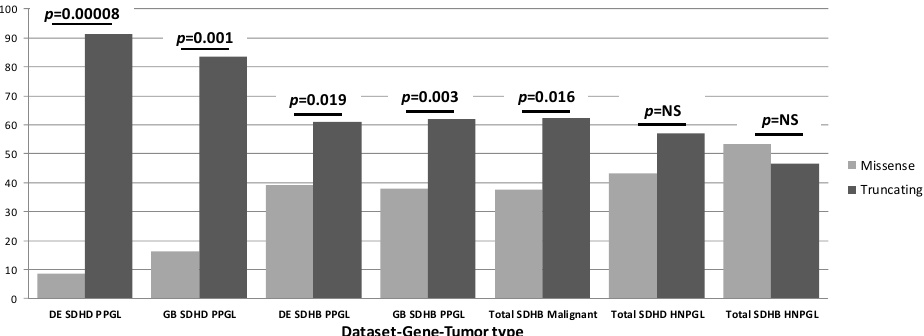
Figure 2. Summary of our SDH genotype-phenotype studies. While all HNPGL data showed an approximately equal distribution of missense and truncating variants, this distribution differed markedly for PPGL cases. The noted differences between variants and the divergent impact across tissues imply distinct biology in both cases. It is important to note that ‘percentage of cases’ refers only to relative numbers of cases attributable to either truncating or missense variants per gene-tumor type and should not be compared across groups. SDHAF2 is not included in this figure or in the relevant studies due to a lack of clinical diversity, as all known clinical cases exhibit solely parasympathetic head and neck paraganglioma.